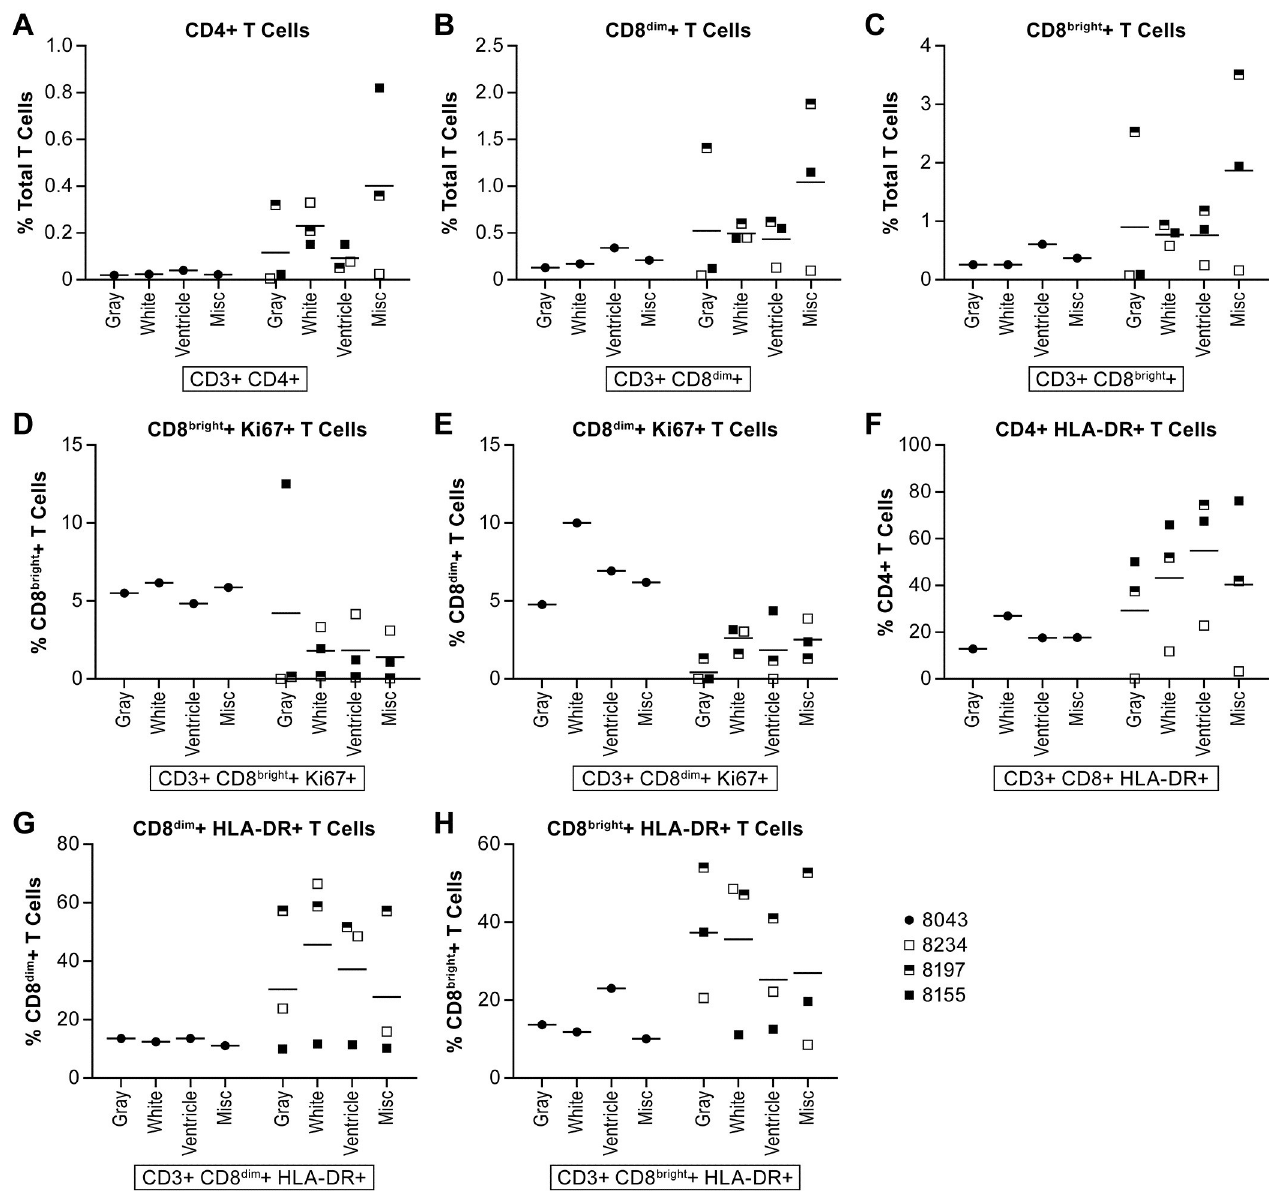
Fig 11. T cell populations in the brain. Tissues were collected as described in the legend for Fig 10. The specific markers used to distinguish cell populations are indicated below the individual panels. Analyses included the Ki67 marker to determine if cell populations were proliferating and the HLA-DR to determine if cells were activated. Animals included in this analysis included 8043 (filled circle), 8234 (open square), 8197 (half filled square) and 8155 (filled square). These analyses included (A)CD4+ T cells; (B) CD8 dim T cells; (C) CD8 bright T cells; (D) proliferating CD8 bright T cells; (E) proliferating CD8 dim T cells; (F) HLA-DR+ CD4+ T cells; (G) HLA-DR+ CD8 dim T cells; (H) HLA-DR+ CD8 bright T cells. The solid lines represent the mean for that dose group.